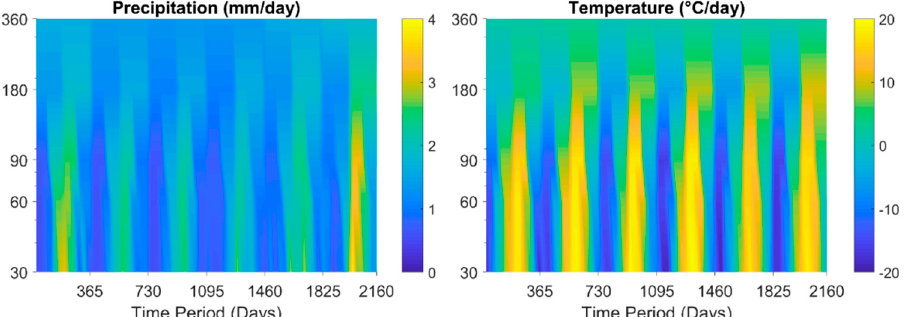
Figure 4. Daily averaged precipitation (mm/day) and air temperature (°C/day) of the NCRB using the Ensemble dataset for moving windows of 30 days, 60 days, 90 days, 180 days and 360 days from 1/1/2000 to 29/11/2005.